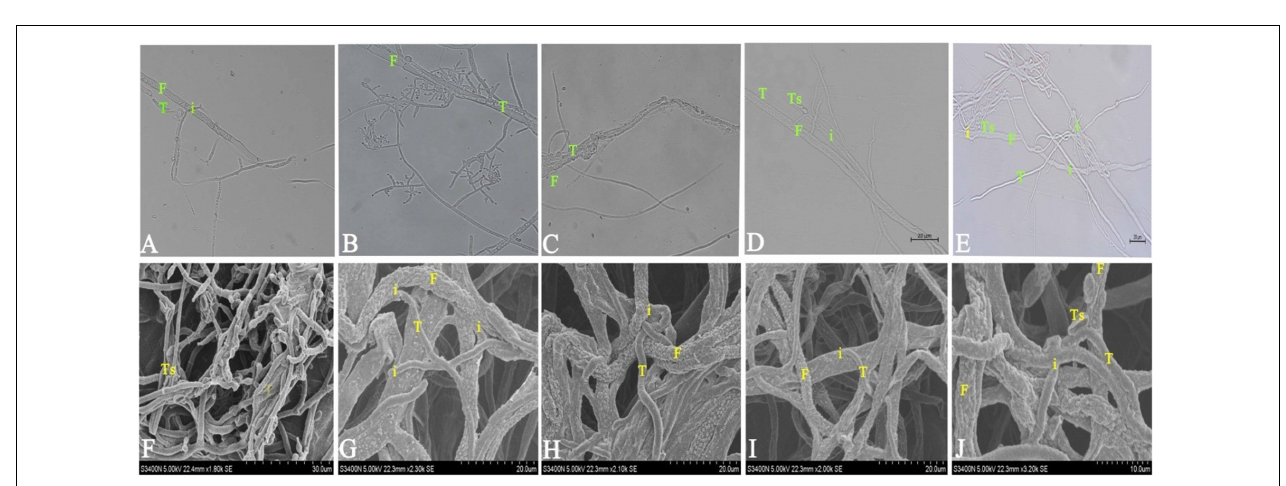
FIGURE 3 | Mycoparasitism of T. longibrachiatum (TG1) (T) against F. pseudograminearum (Fg) (F) observed under light microscopy at 40 × magnification and scanning electron microscopy (SEM) at 4 days after inoculation using dual plate assay at 150 mM NaCl concentration. (A) TG1wrapped around F. pseudograminearum hyphae with obvious degradation of F. pseudograminearum cell wall. (B) TG1 conidial growth internally and externally on F. pseudograminearum hyphae. (C) TG1 hyphal disruption, penetration and breakage of F. pseudograminearum hyphae. (D) TG1 spore germ tube (Ts) growing on F. pseudograminearum hyphae. (E) F. pseudograminearum hyphae looped by TG1 hyphae and TG1 hyphae extending parallel to F. pseudograminearum showing hyphal depression. (F–H) SEM images of TG1 (T) coiling the hyphae of F. pseudograminearum . (I,J) SEM images of TG1 coiling and invading the hyphae